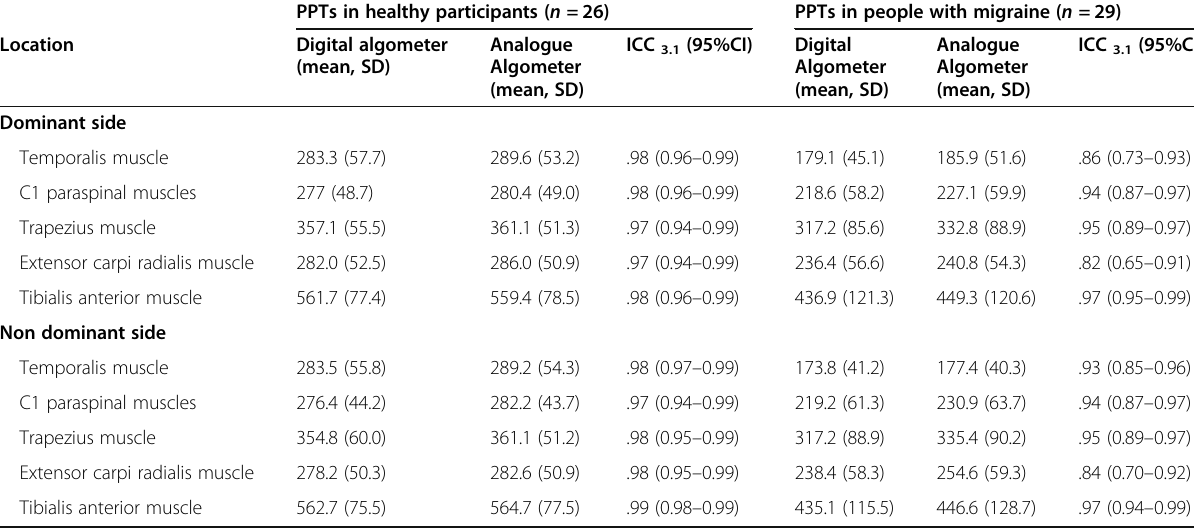
Table 2 Pressure pain thresholds and concurrent validity in healthy participants and people with migraine PPTs in healthy participants ( n = 26)